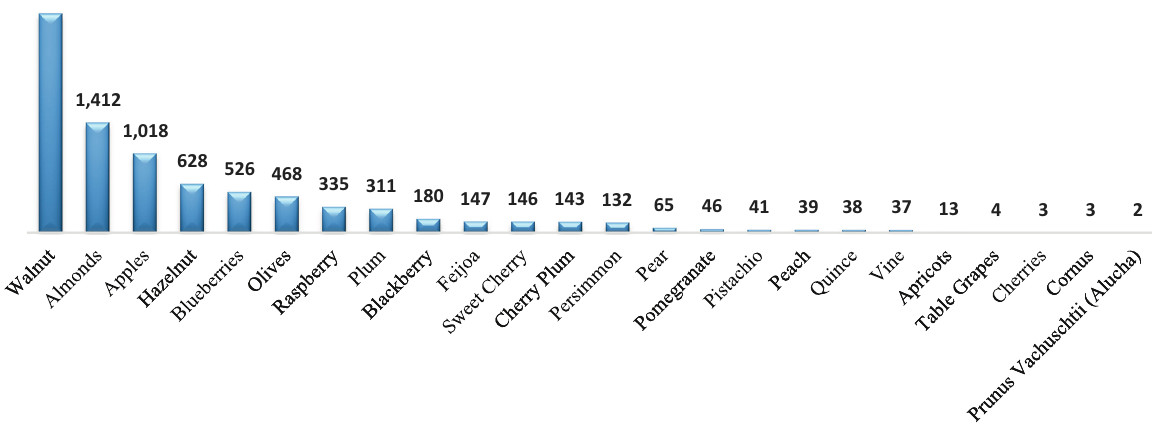
Figure 3: Planted area ( ha ) by agricultural product in 2015 – 2019. Source: NNLE Rural Development Agency.